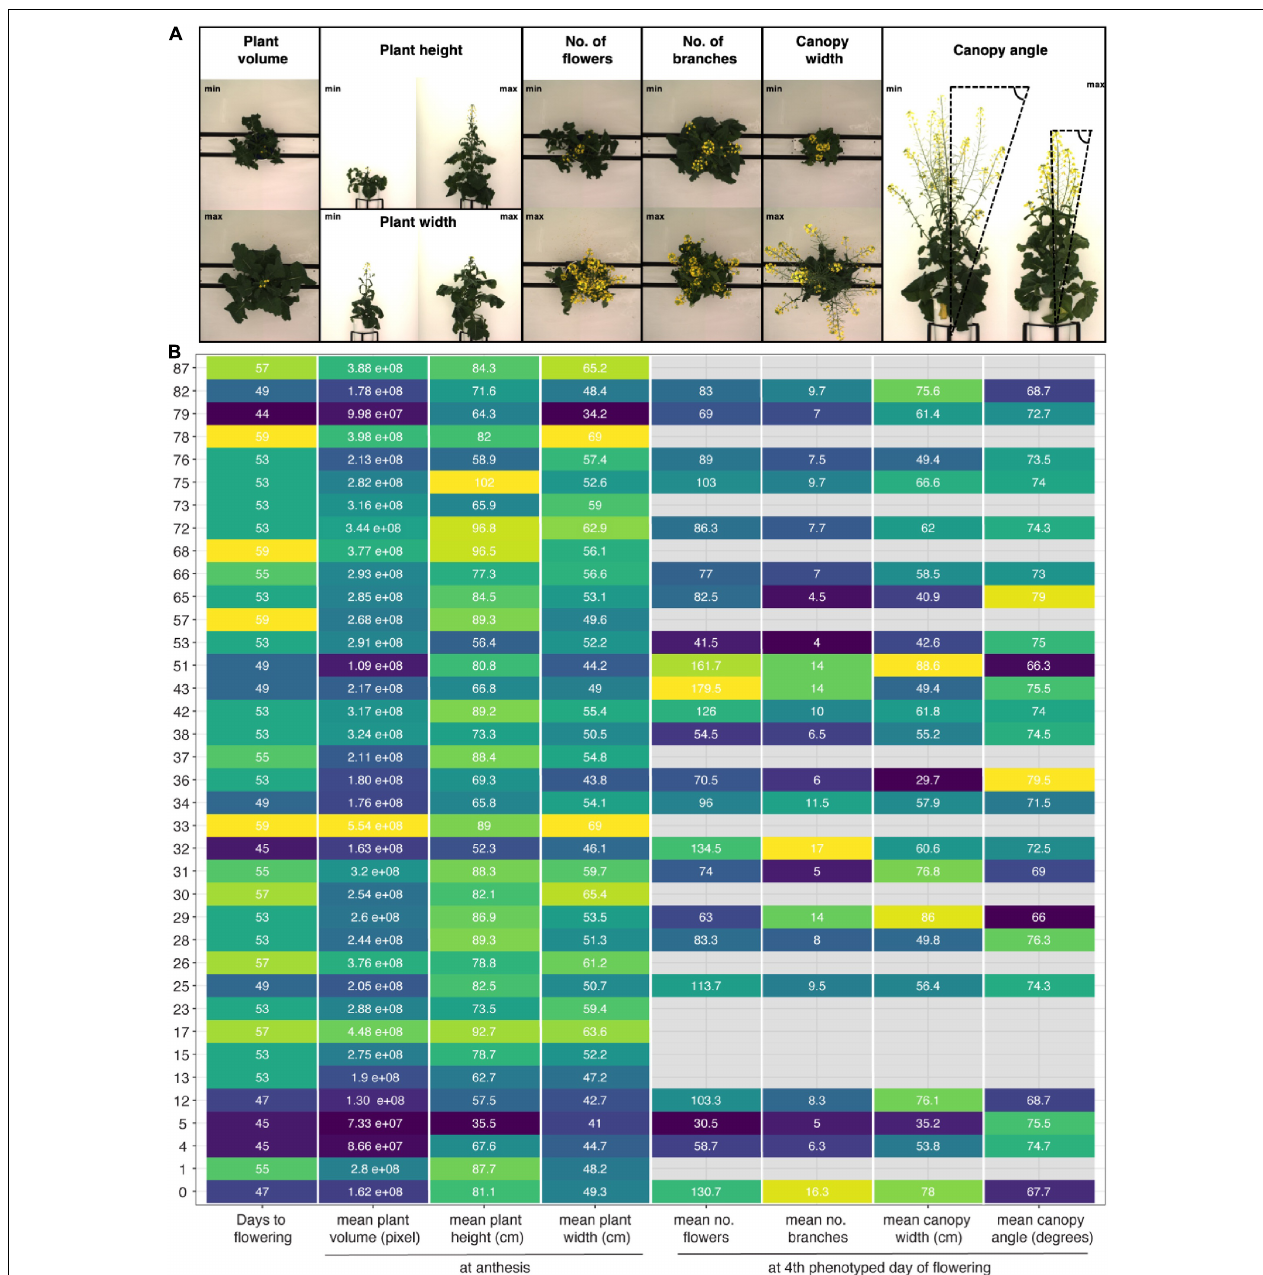
FIGURE 7 | Morphological diversity among founder lines of SKBnNAM based on eight selected growth traits extracted from the dataset. (A) Images show individuals representing minimum and maximum values for each growth trait (except for days to flowering). (B) Mean values for each trait and genotype (control group only). Tiles are colored based on normalized trait means (darker colors indicating lower values, lighter colors indicating higher values). Absolute mean values are given in each tile. Only genotypes that started to flower before DAS 59 are included in this plot ( n = 37).